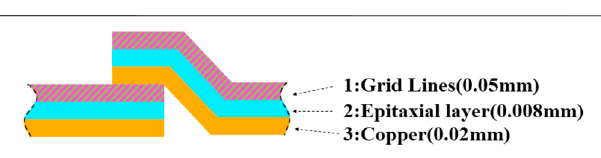
FIGURE 2 | The multi-layer structure and connection of the adopted solar cell.